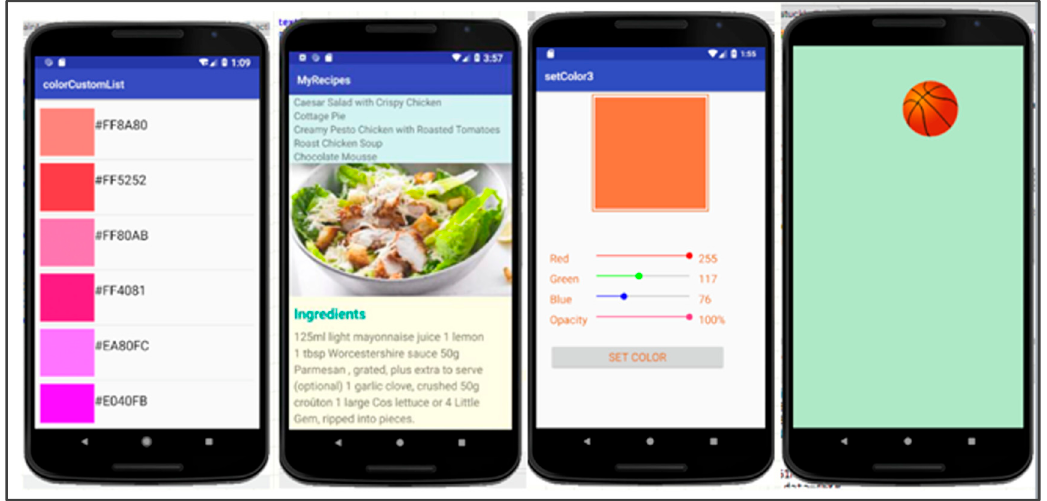
Figure 5. Other examples that were used in teaching the mobile app development course.